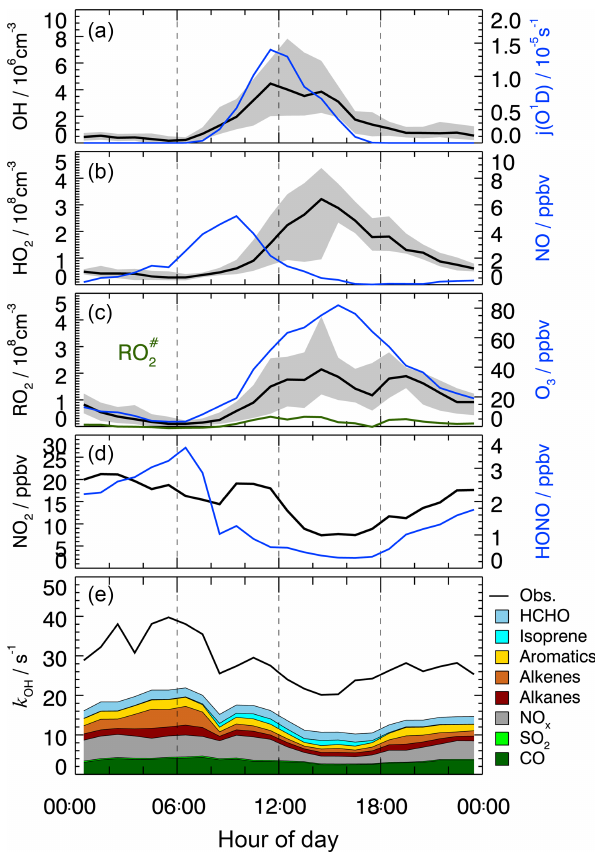
Figure 1. Median diurnal profiles of measured OH, HO 2 , RO 2 , RO # , k OH , j (O 1 D), NO, NO 2 , O 3 , and HONO. For OH, HO 2 , and 2 RO 2 , the grey band around the median (black lines) denotes the 25% and 75% percentiles of the distributions. In the lowest panel, colored areas show the speciated reactivity contributions from mea- sured OH reactants.